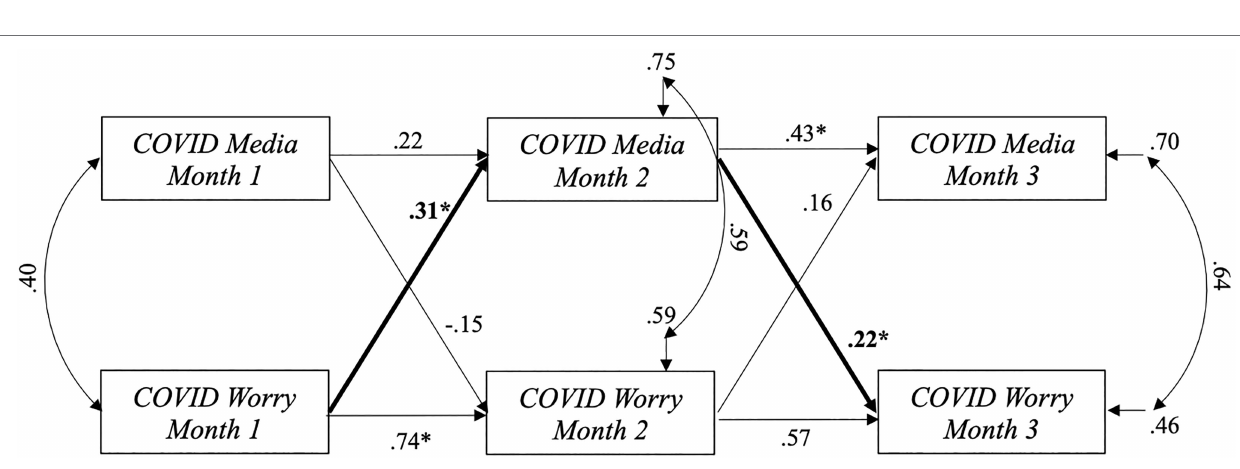
. = R 0.54 2 worry media